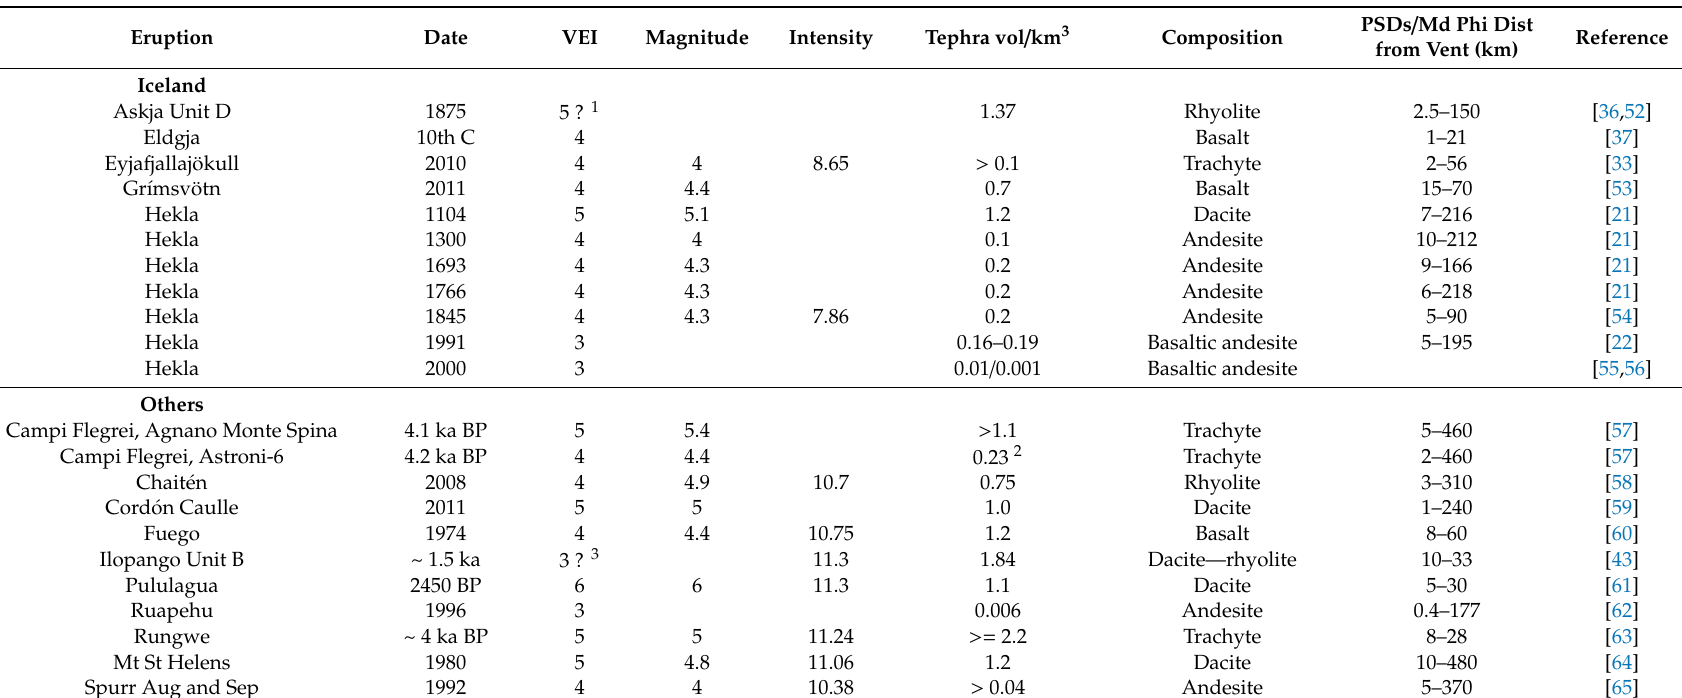
Table 2. Details of magmatic eruptions. VEI, magnitude and intensity details come from references shown, the LaMEVE database [34] and the Global Volcanism Program catalogue of Holocene eruptions